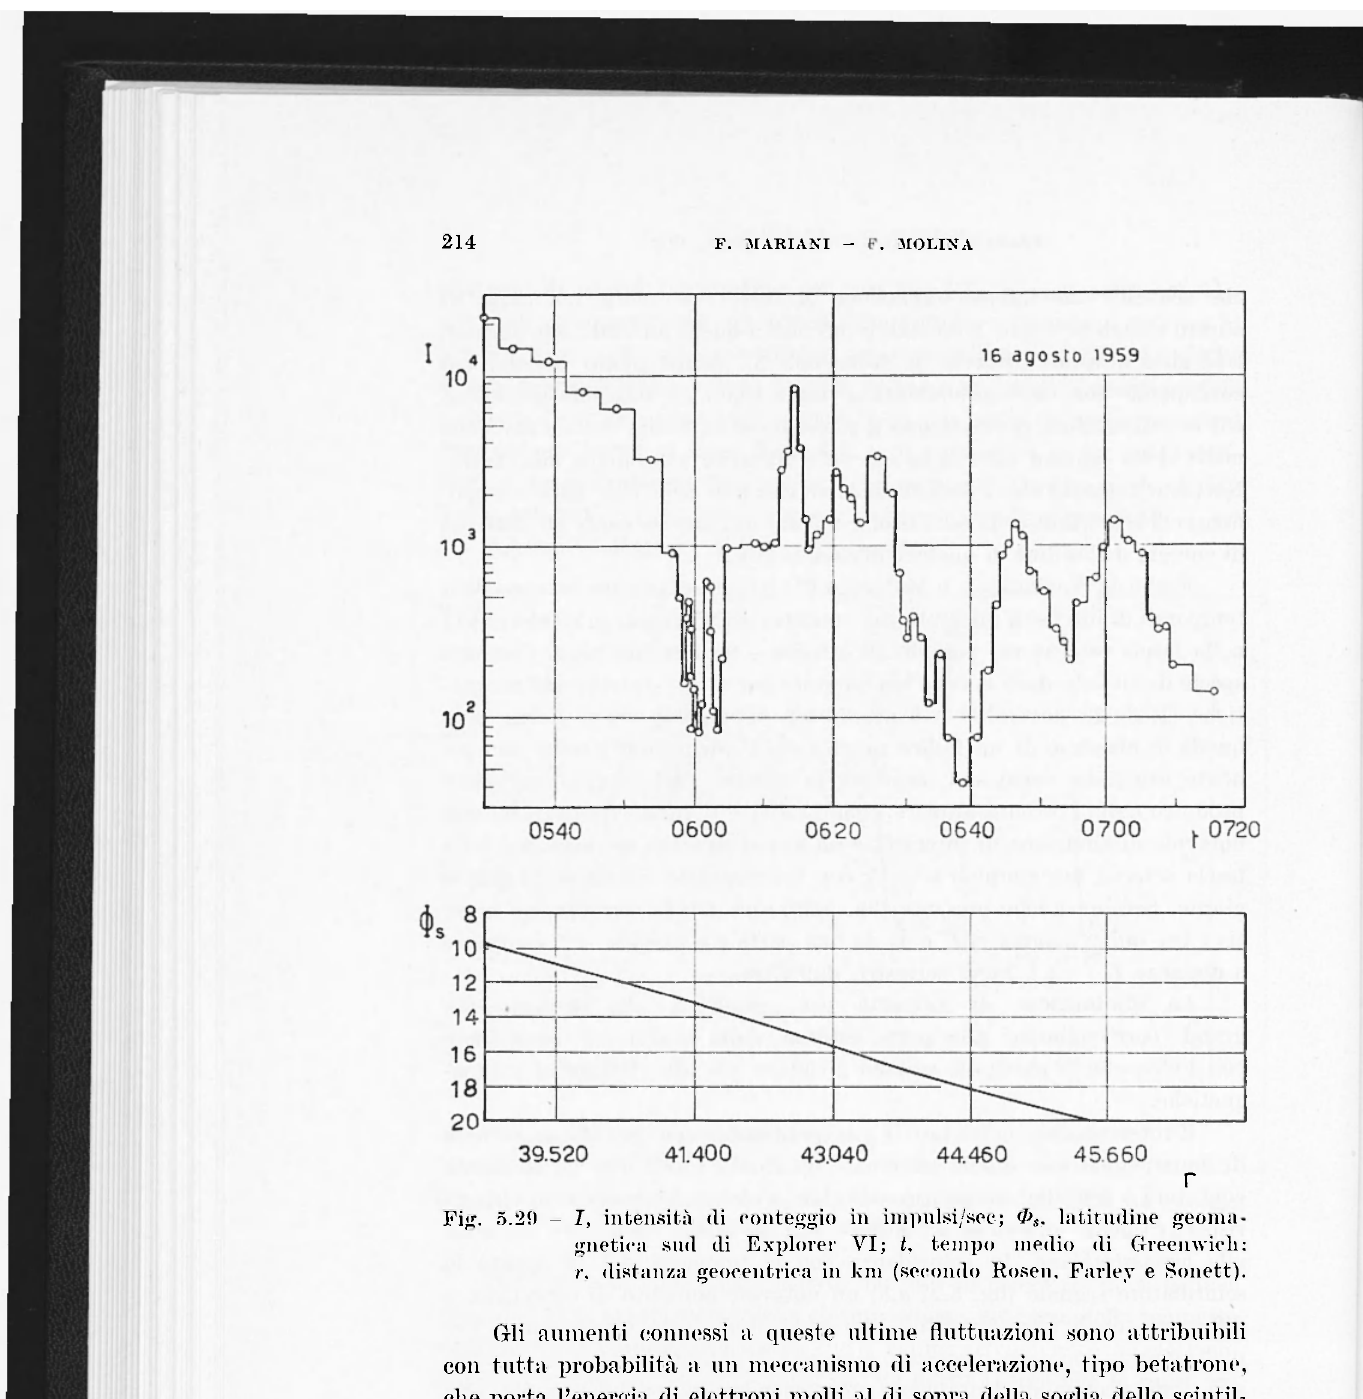
Fig. 5.29 - I, intensità di conteggio in impulsi/sec; 3> s , latitudine geoma- gnetica sud di Explorer VI; t , tempo medio di G-reenwich; r, distanza geocentrica in km (secondo Roseli, Farley e